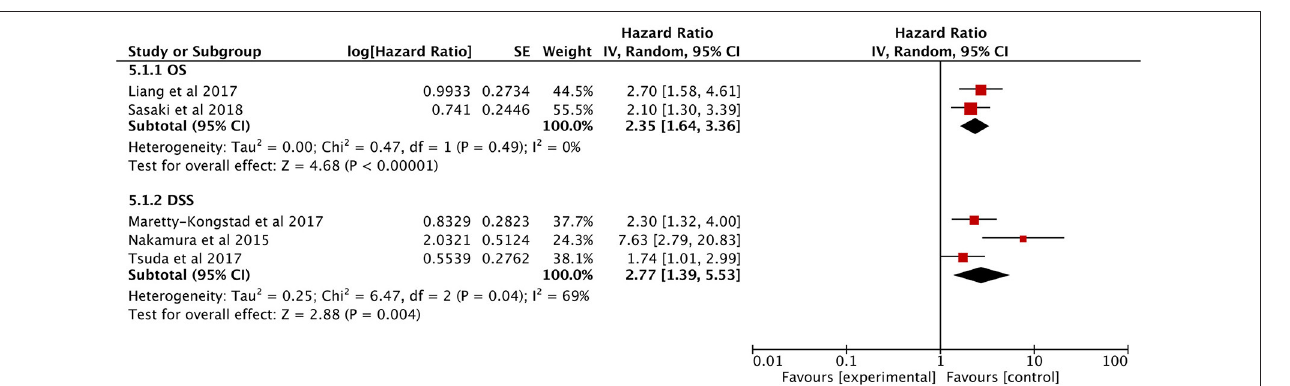
FIGURE 7 | Forest plots of the Prognostic effect of GPS for OS/DSS.